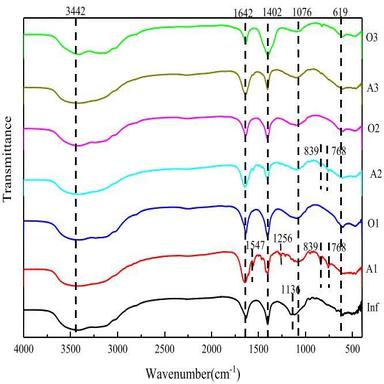
FTIR spectra of the influent and effluent from different stages.